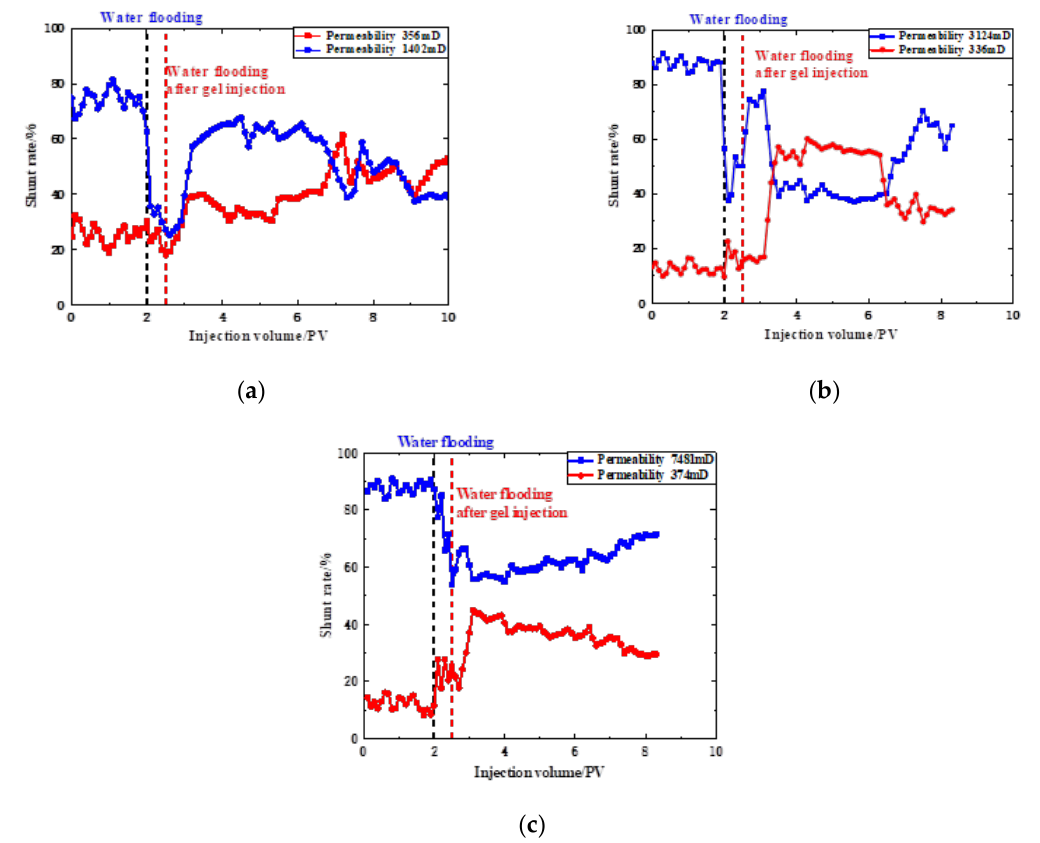
Figure 11 . ( a ). Shunt rate of high- and low-permeability pipes with an extreme difference of 4. ( b ). Shunt rate of high- and low-permeability pipes with an extreme difference of 8. ( c ) Shunt rate of high- and low-permeability pipes with an extreme difference of 20.